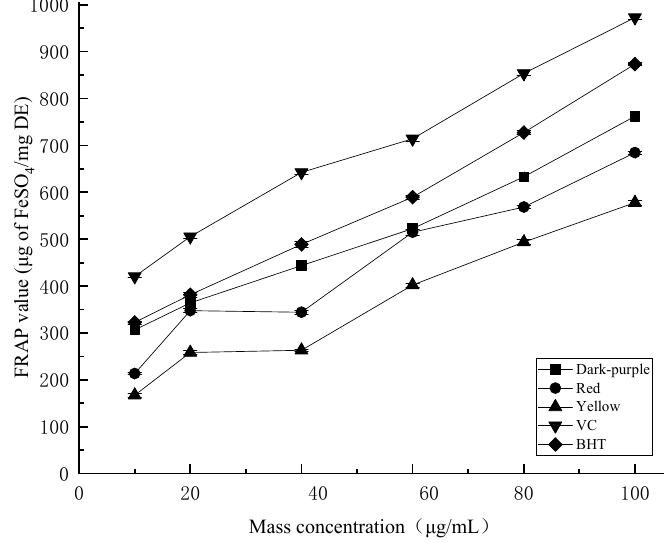
Figure 6. Ferric reducing antioxidant power of essential oil for different colors of P. delavayi flowers.